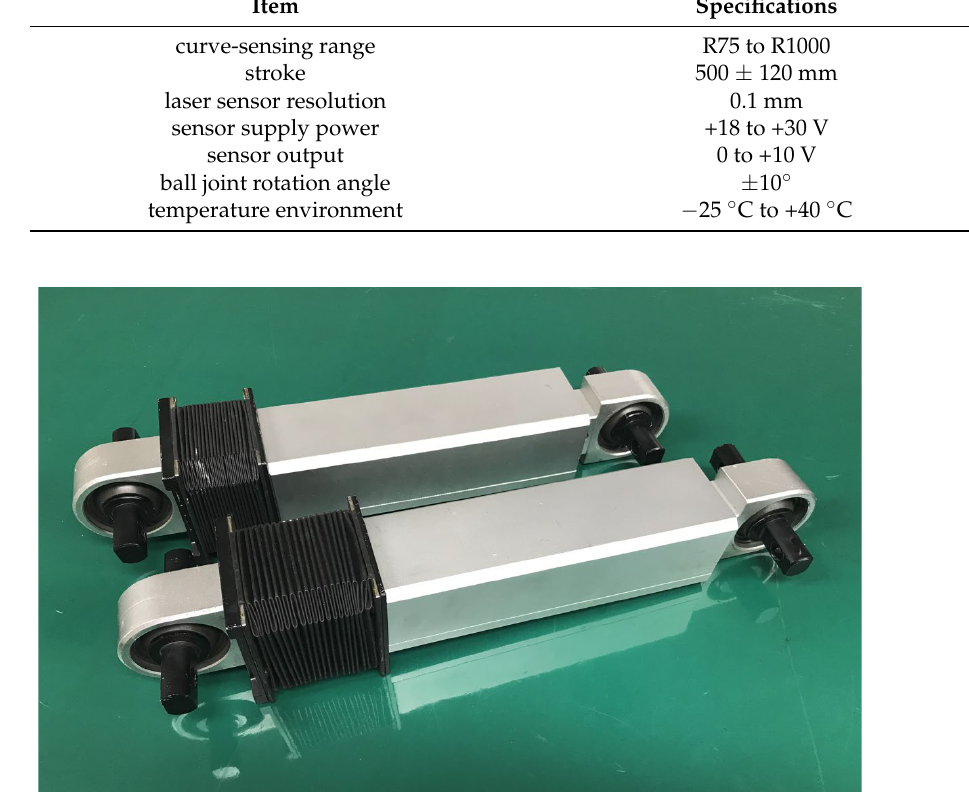
Figure 12. Curvature sensor prototype.